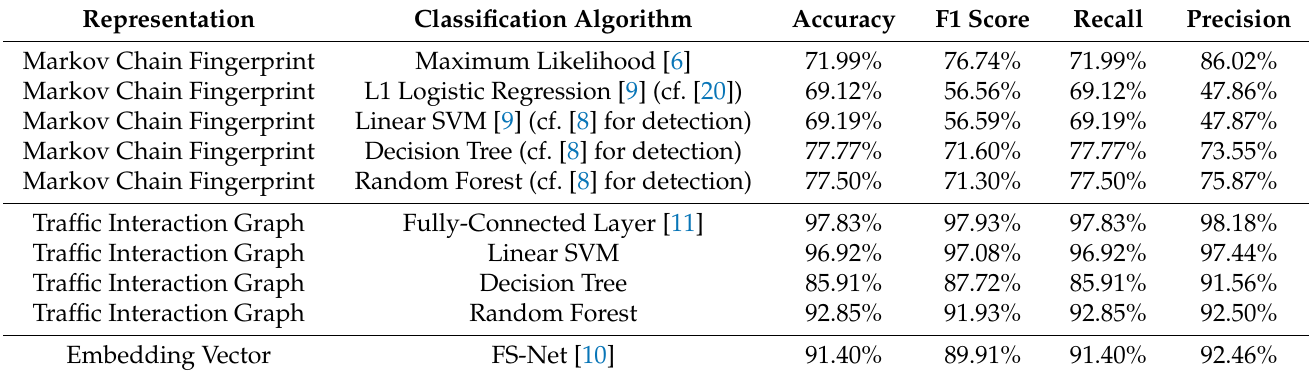
Table 2. Malware family classification results in terms of accuracy, F1 score, recall, and